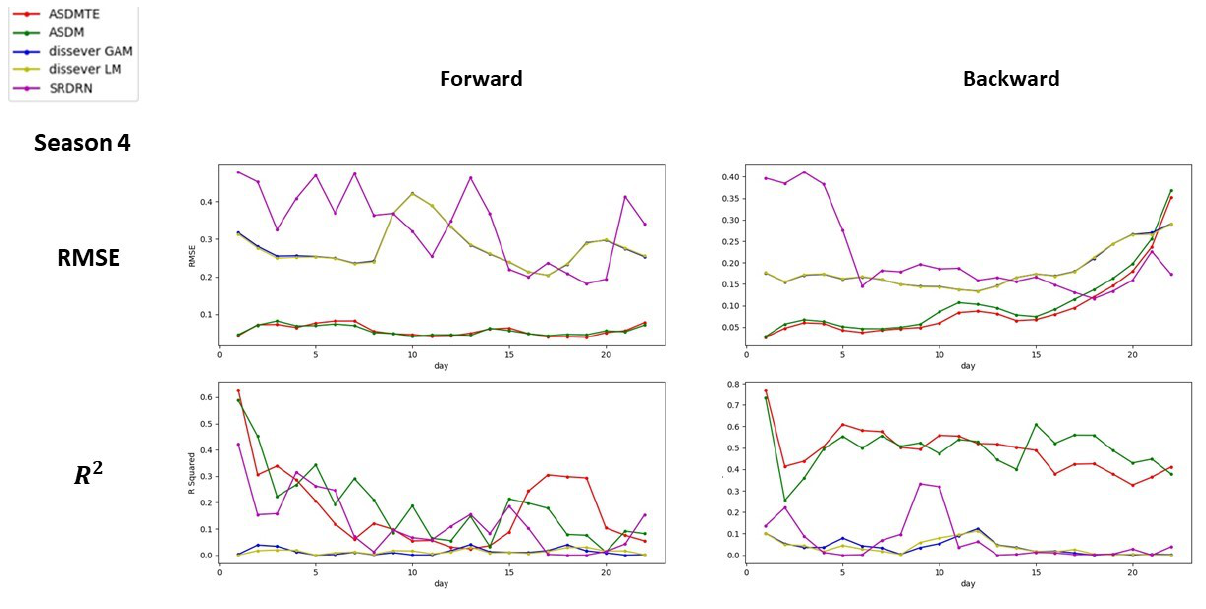
Figure A4. Downscaling performance of ASDM, ASDMTE, SRDRN, dissever GAM and dissever LM in Season 4. Please refer to Figure 4 and Section 2.2.3 for the definition of Season